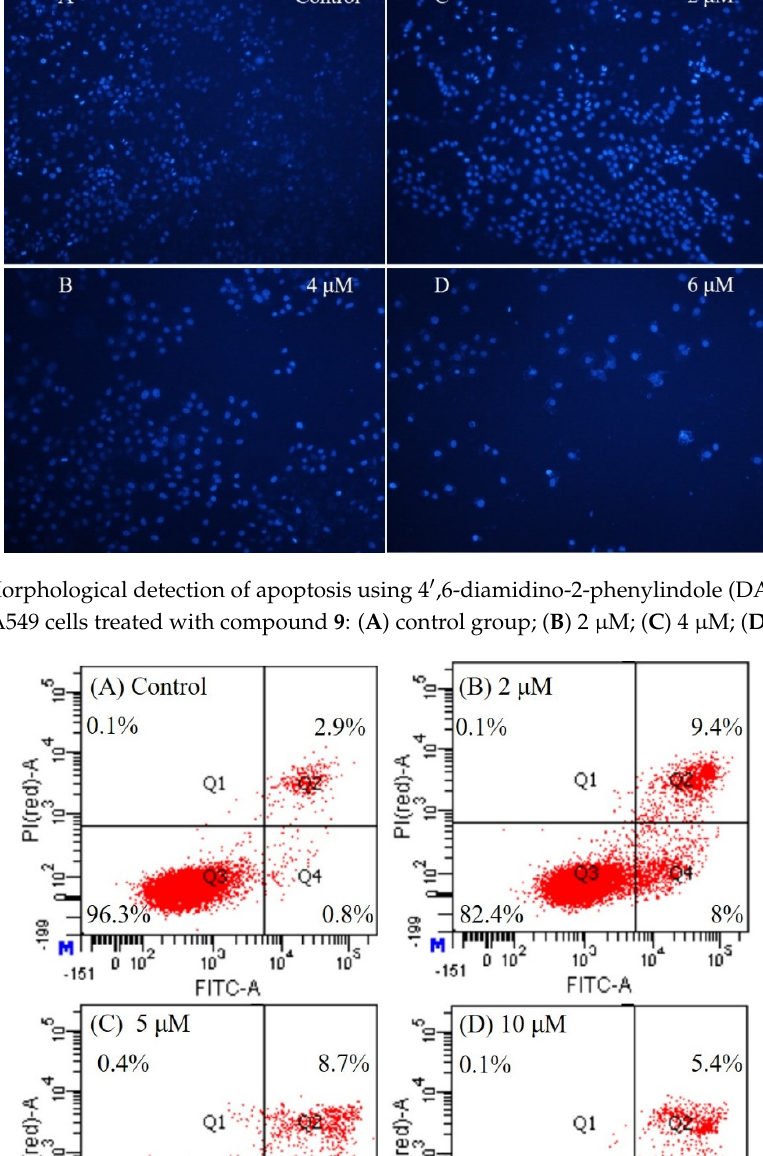
Figure 7. Detection of apoptosis using Annexin V fluorescein isothiocyanate (FITC)/propidium iodide (PI) staining on A549 cells treated with compound 9 : ( A ) control group; ( B ) 2 µM; ( C ) 5 µM; ( D ) 10 µM.